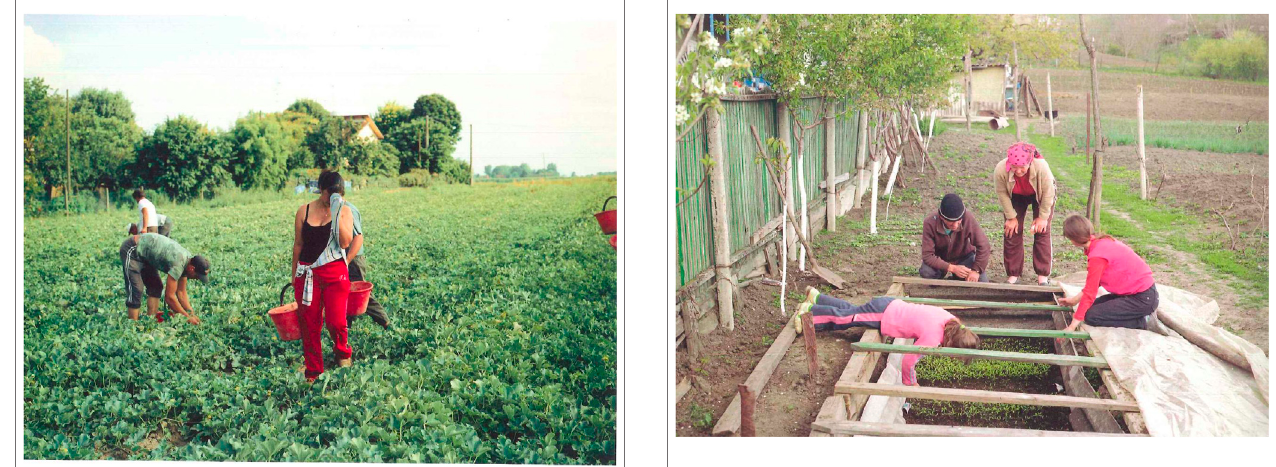
Photo Andrea Diefenbach